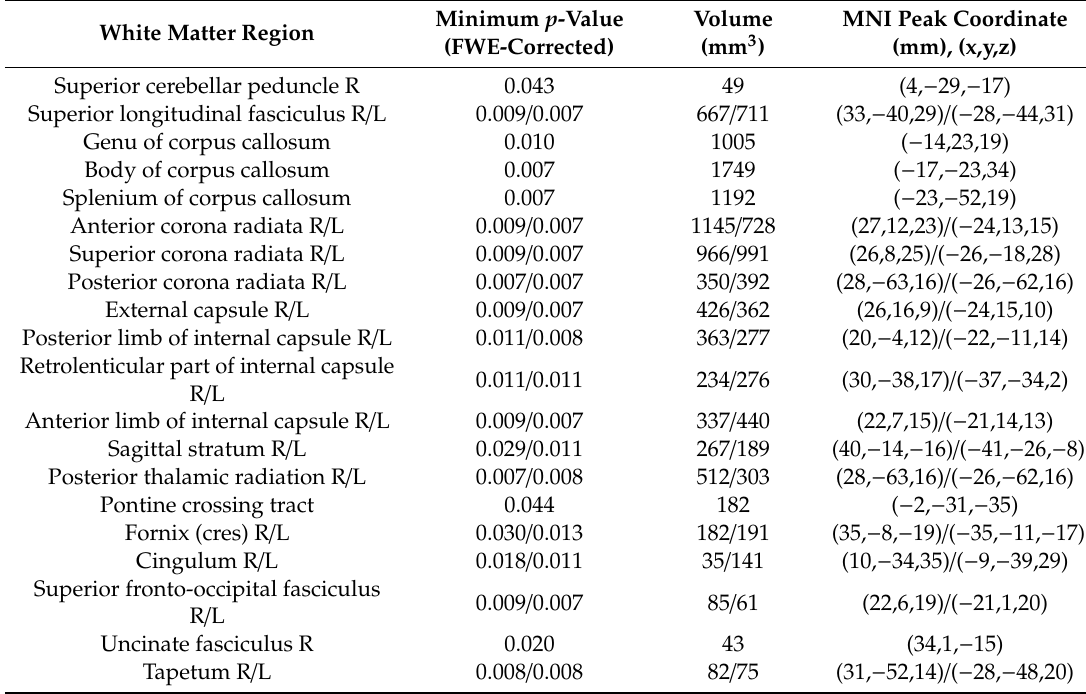
Table A10. White matter regions from the ICBM-DTI-81 White Matter Atlas for which significant decreased RD values were found in CM compared to EM including the duration of the migraine, presence of aura and medication overuse headache as covariates.